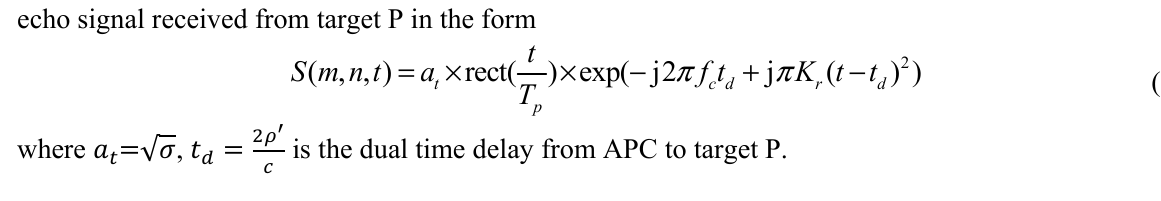
Figure 1. Downward looking sparse linear array three dimensional synthetic aperture radar (DLSLA 3-D SAR) imaging